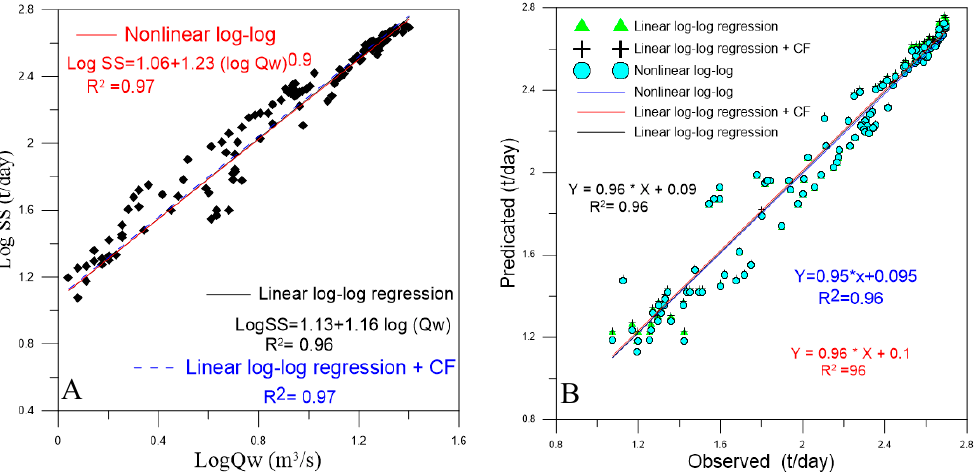
Figure 8. ( A ) The developed rating curves for station Bulbula; and ( B ) Predicted and observed